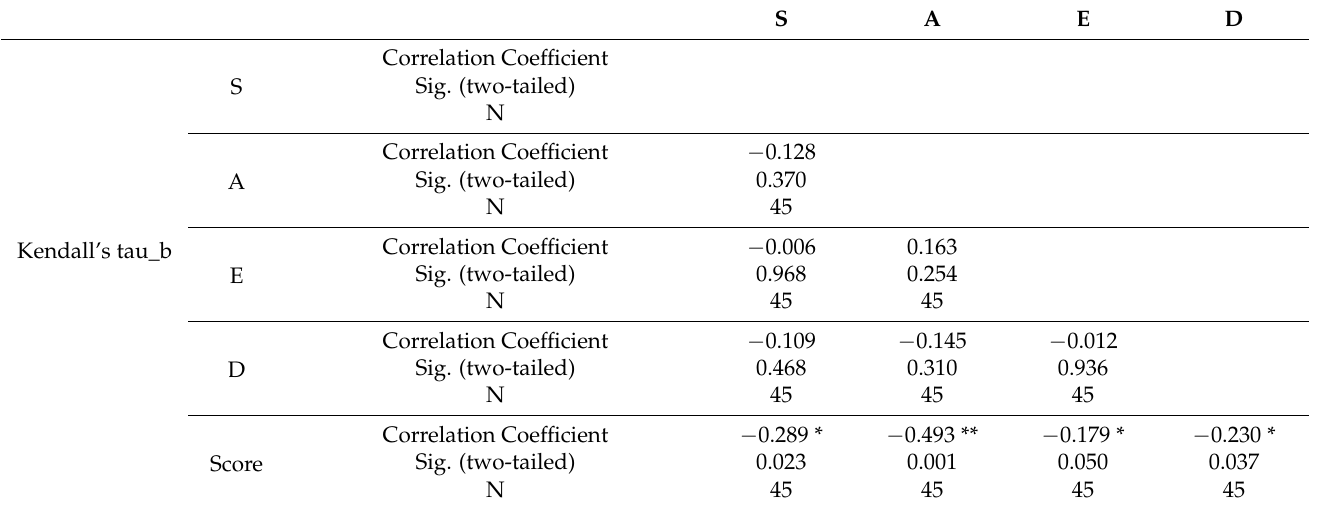
Table 7. Kendall rank correlation analysis.